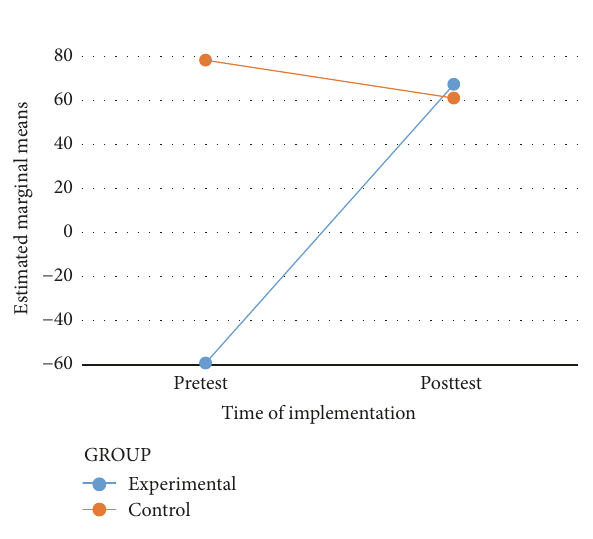
Figure 5: Graph of interactions for UEIQ.